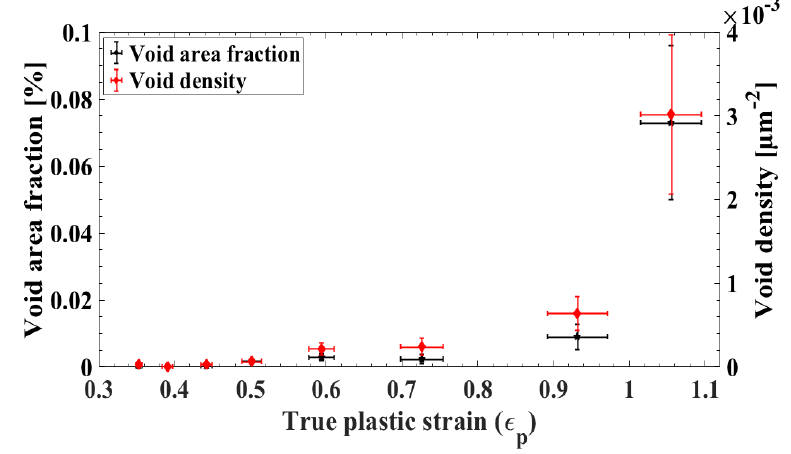
Figure 5 . Quantitative analysis of voids’ evolution as a function of true plastic strain. Figure 5. Quantitative analysis of voids’ evolution as a function of true plastic